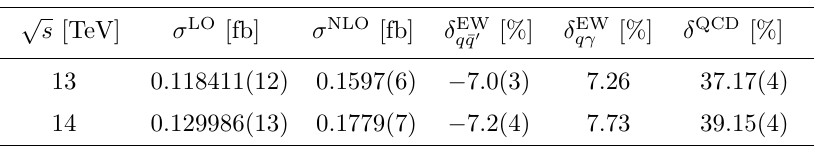
, (cid:14) EW , and q(cid:13) q (cid:22) q 0 p s = 8 TeV without the additional phase-space